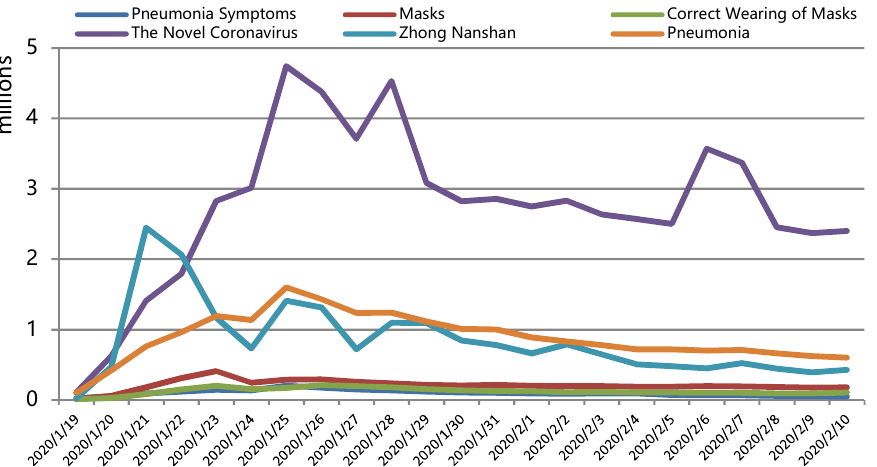
Figure 4. The number of six terms most relevant to the novel coronavirus epidemic searched by Chinese netizens. Table 1. Items of traffic control and social